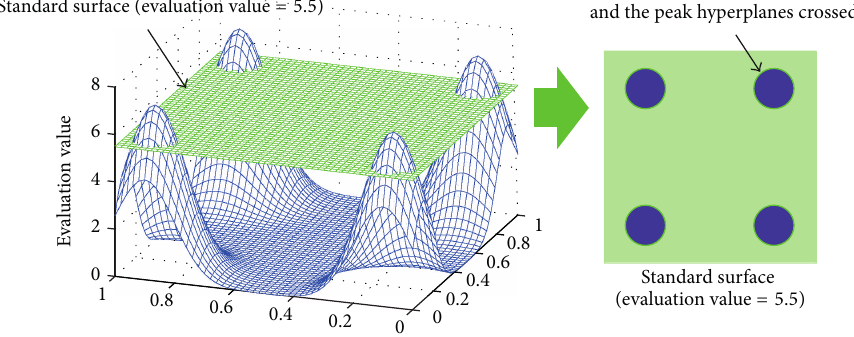
Figure 9: Definition of peak field.